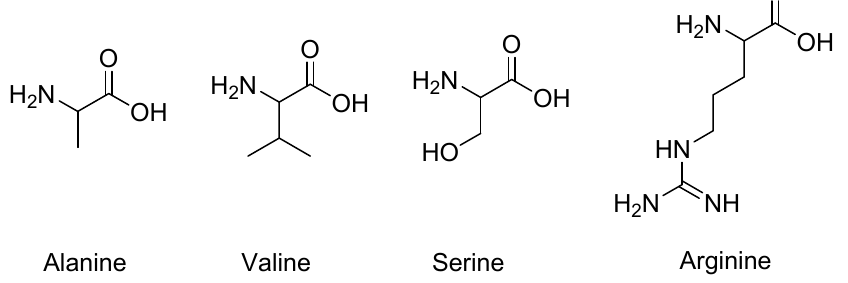
Figure 2. Amino acids that were electrochemically evaluated.